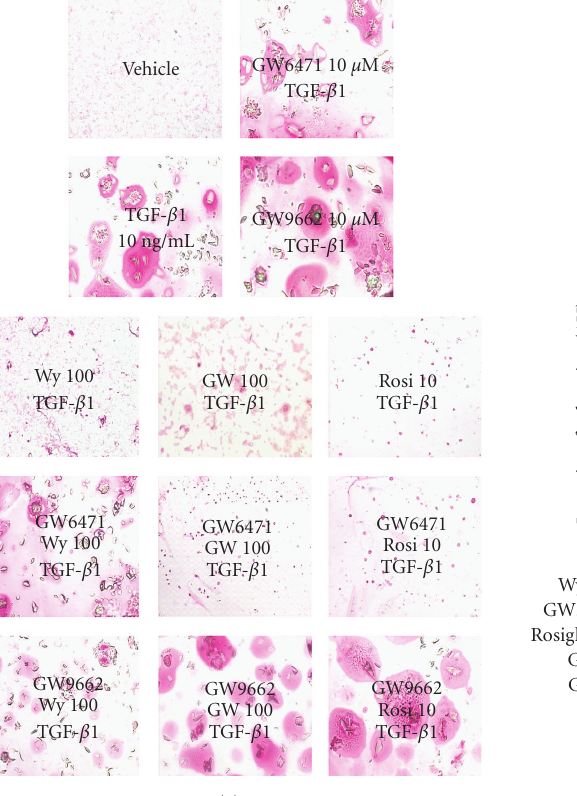
e ff ect of TGF- β 1 on its own expression [34], PPAR